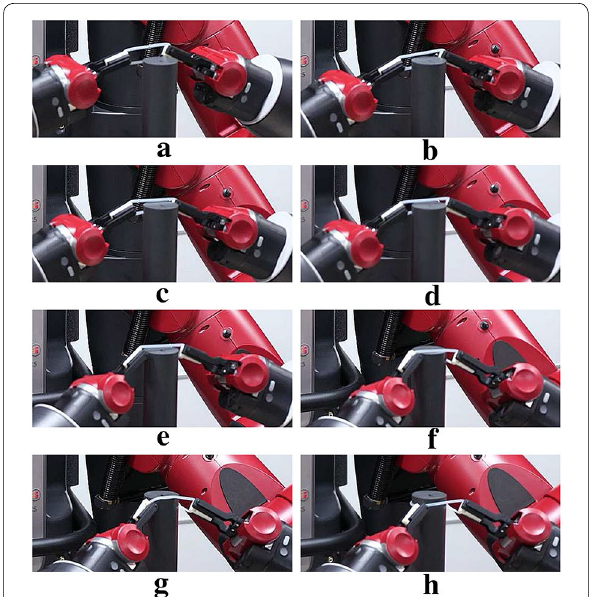
Fig. 9 Snapshots of the assembly experiment using an o‑ring (silicon rubber) at a initial state, b at right arm key point 2, c between right arm key point 2 and left arm key point 4, d between left arm key point 4 and right arm key point 3, e at right arm key point 4, f between right arm key point 5 and left arm key point 6, g end of the assembly task and h after releasing the o‑ring band from the right gripper